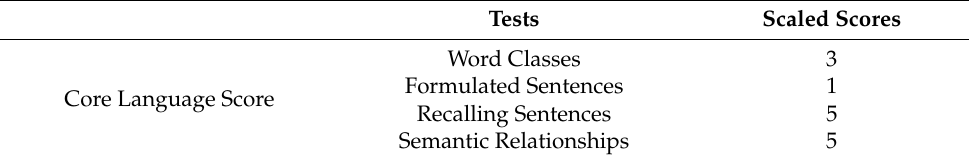
Table 2. Scaled Scores for